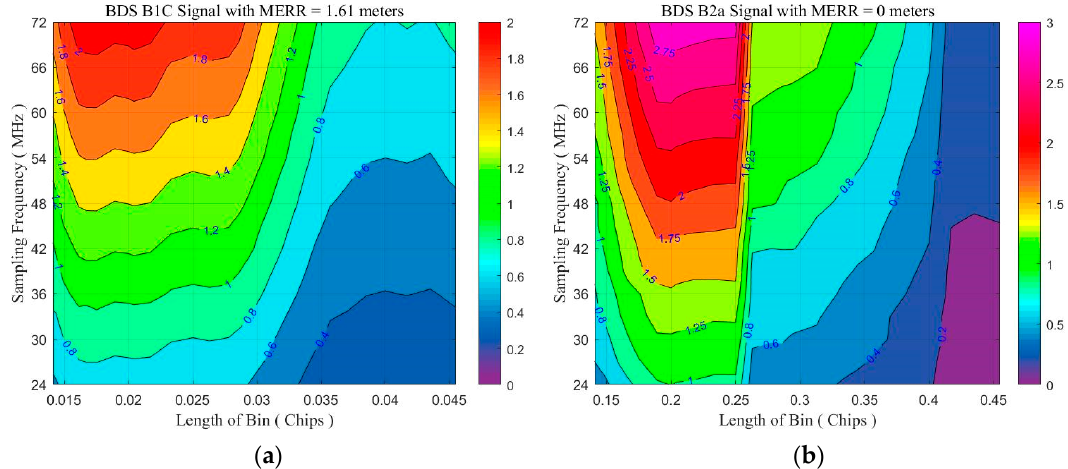
Figure 6. Contours of FoM values across the considered ranges of code-phase bin lengths and sampling frequency. ( a ) B1C signal with MERR = 1.61 m; ( b ) B2a signal with MERR = 0 m.